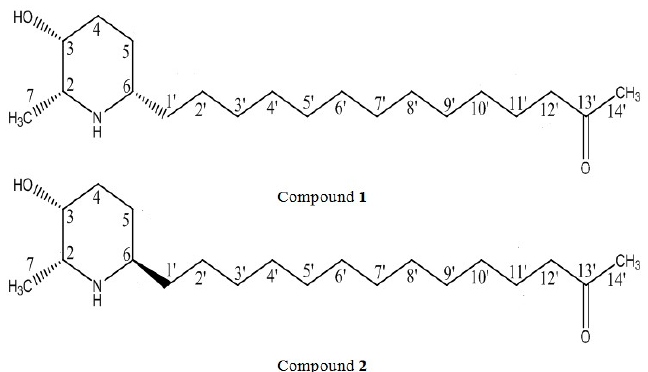
Figure 1. Chemical structure of piperidine alkaloids ( + )-spectaline ( 1 ) and iso-6-spectaline ( 2 ) isolated from S. spectabilis .